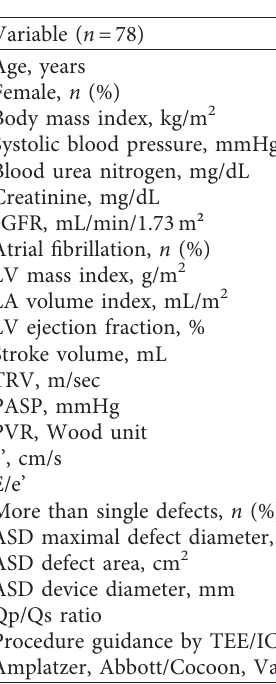
Figure 1: Schematic diagram of study patient selection process. ASD, atrial septal defect; ESRD, end-stage renal disease; TTE, transthoracic echocardiography; TEE, transesophageal echocardiography; ICE, intracardiac Table 1: Baseline clinical characteristics and echocardiographic measurements in patients with ASD.